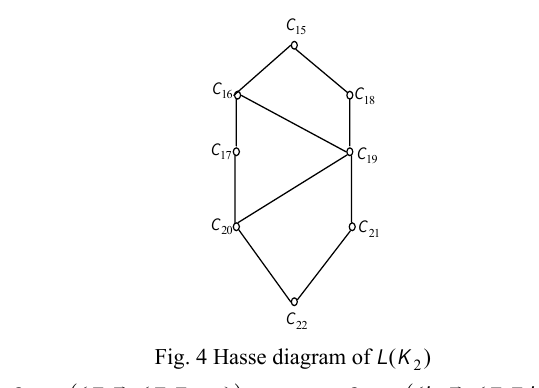
Fig. 4 Hasse diagram